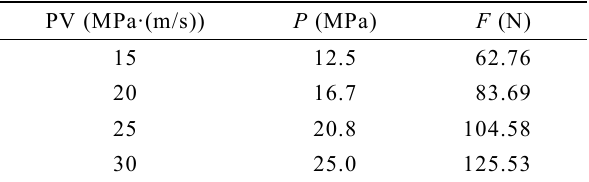
Experimental design under the water-lubricated